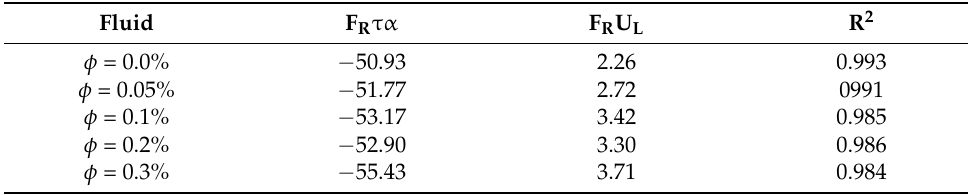
Table 7. The F R τα , F R U L parameters and their coefficients of determination (R 2 ).